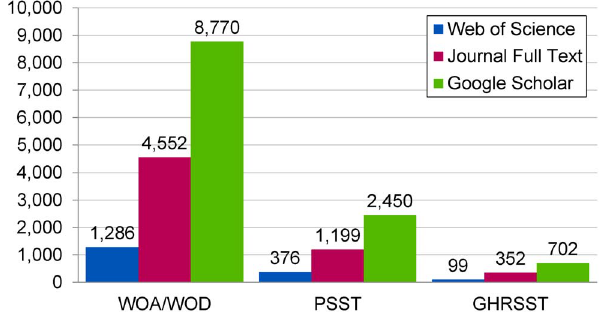
Figure 1. Citation counts retrieved for three oceanographic data sets from three data sources.